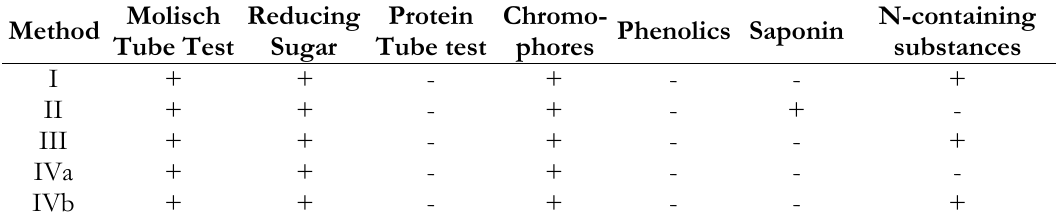
Table I. Identification of chemical group content in isolates from three different methods Method